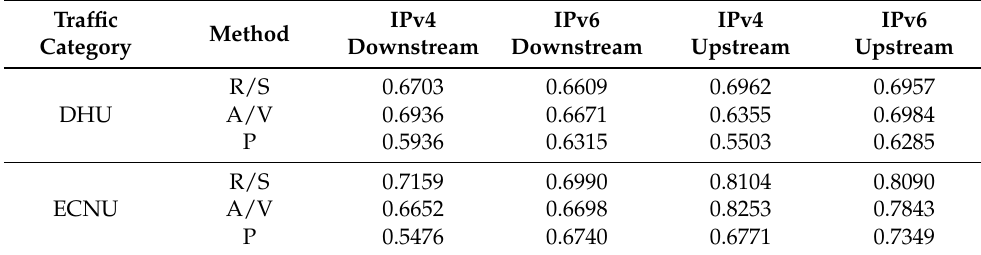
Table 1. The values of Hurst exponents of IPv4 and IPv6